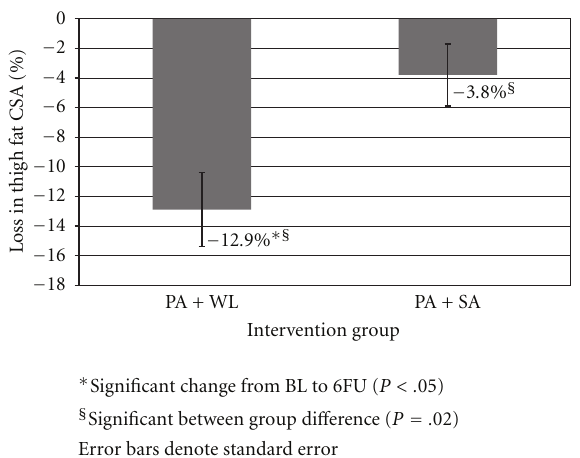
Figure 2: Percent change in total thigh fat CSA from Baseline to 6-month followup by intervention group.